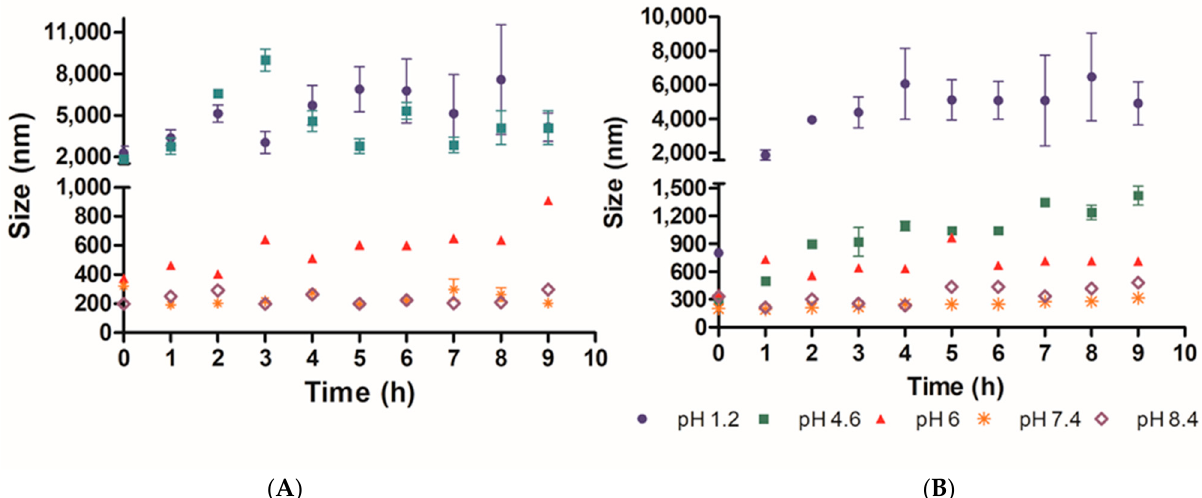
Figure 7. Microgel stability of polyacrylic acid/ Schizochytrium sp. (PAA/Schizo) microgels was analyzed by determining the changes in particle average size (size) and polydispersity index (PDI) of samples over 9 h, at ( A ) 25 and ( B ) 37 °C at different pH values. PAA/Schizo microgels showed higher stability at 7.4 and 8.4 pH values. Data shown is the mean of three independent measurements ± standard deviation (SD).